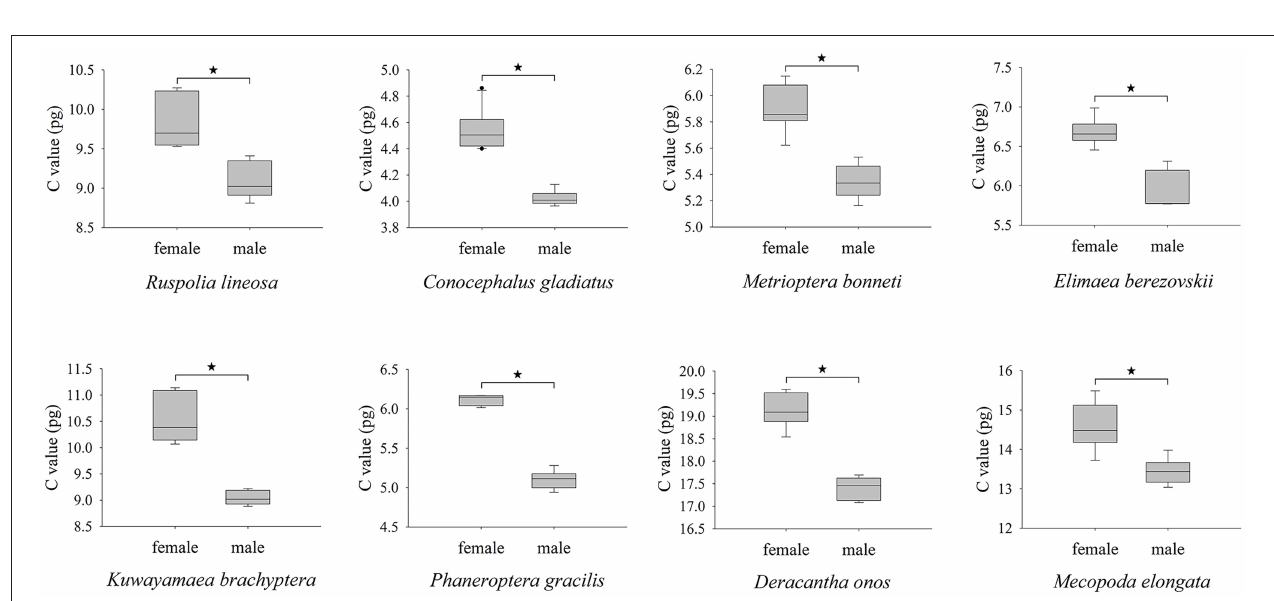
FIGURE 2 | Comparative analysis of the genome sizes of females and males in eight Ensifera species. *Indicates a significant difference between both sexes ( P < 0.01).